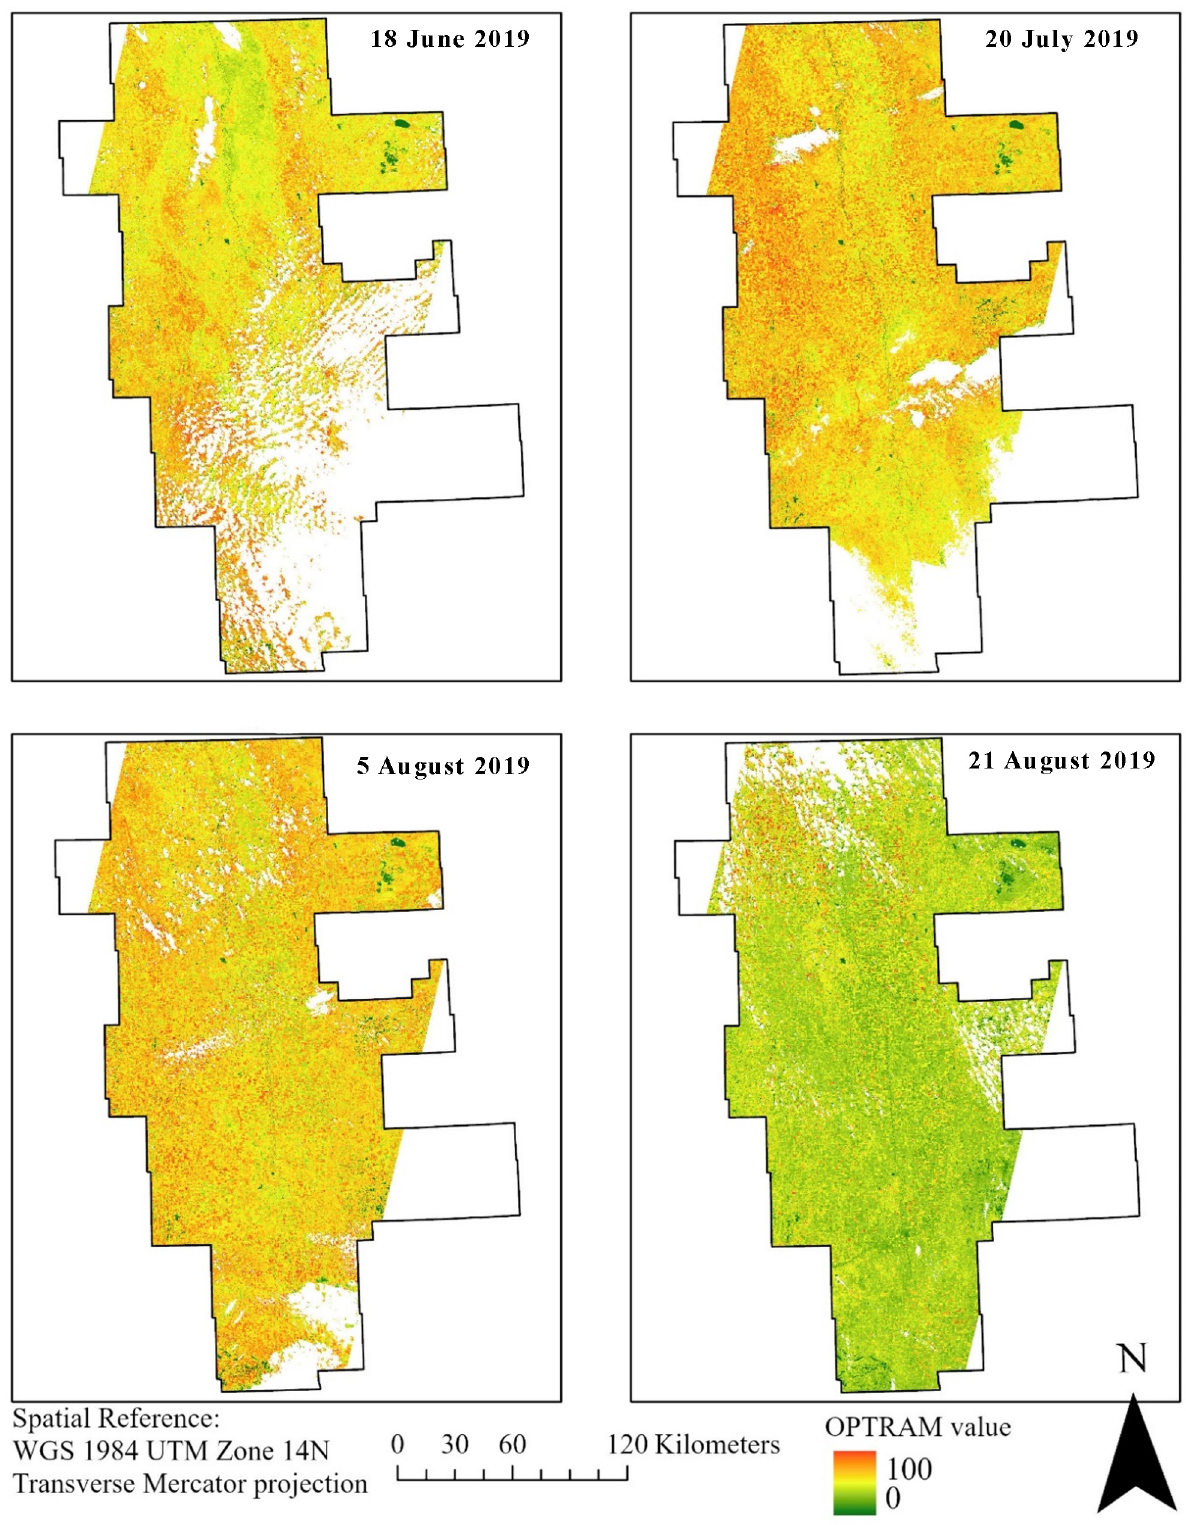
Figure 7. Surface SM maps generated with OPTRAM using Landsat 8 images for different dates (18 June, 21 July, 5 August, 21 August) of the 2019 growing season in the RRVN. White pixels represent maxed pixels due to water bodies, shadows, clouds, and rural/urban areas.